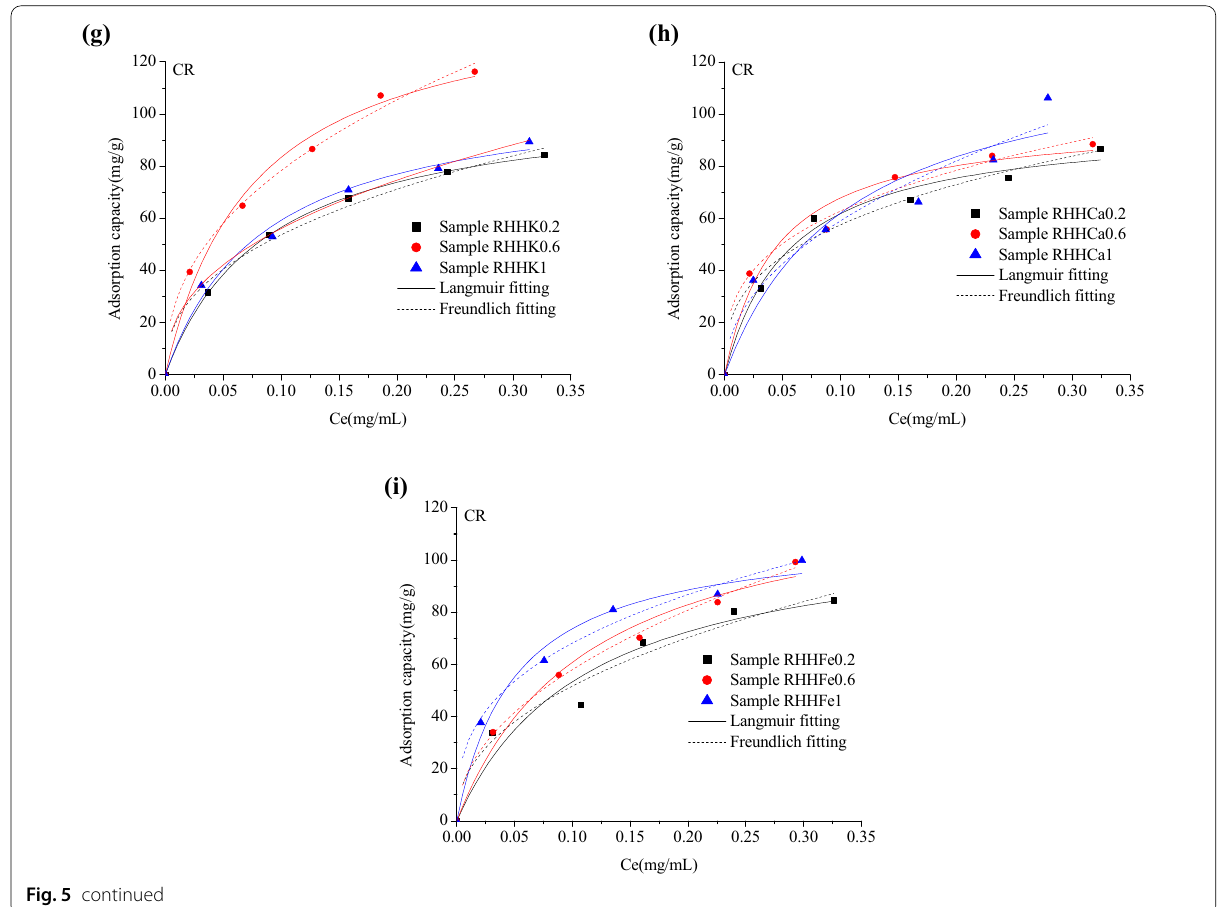
file 1: Table S5. It is obvious that the adsorption capac- ity of 2-naphthol onto RHHCa0.6 sharply decreases with increasing temperature from 298 to 308 K,